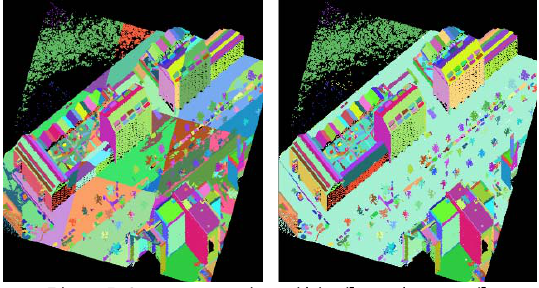
Figure 5. Segment merging within tiles and across tile boundaries. Left: segmentation results per tile. Right: merged